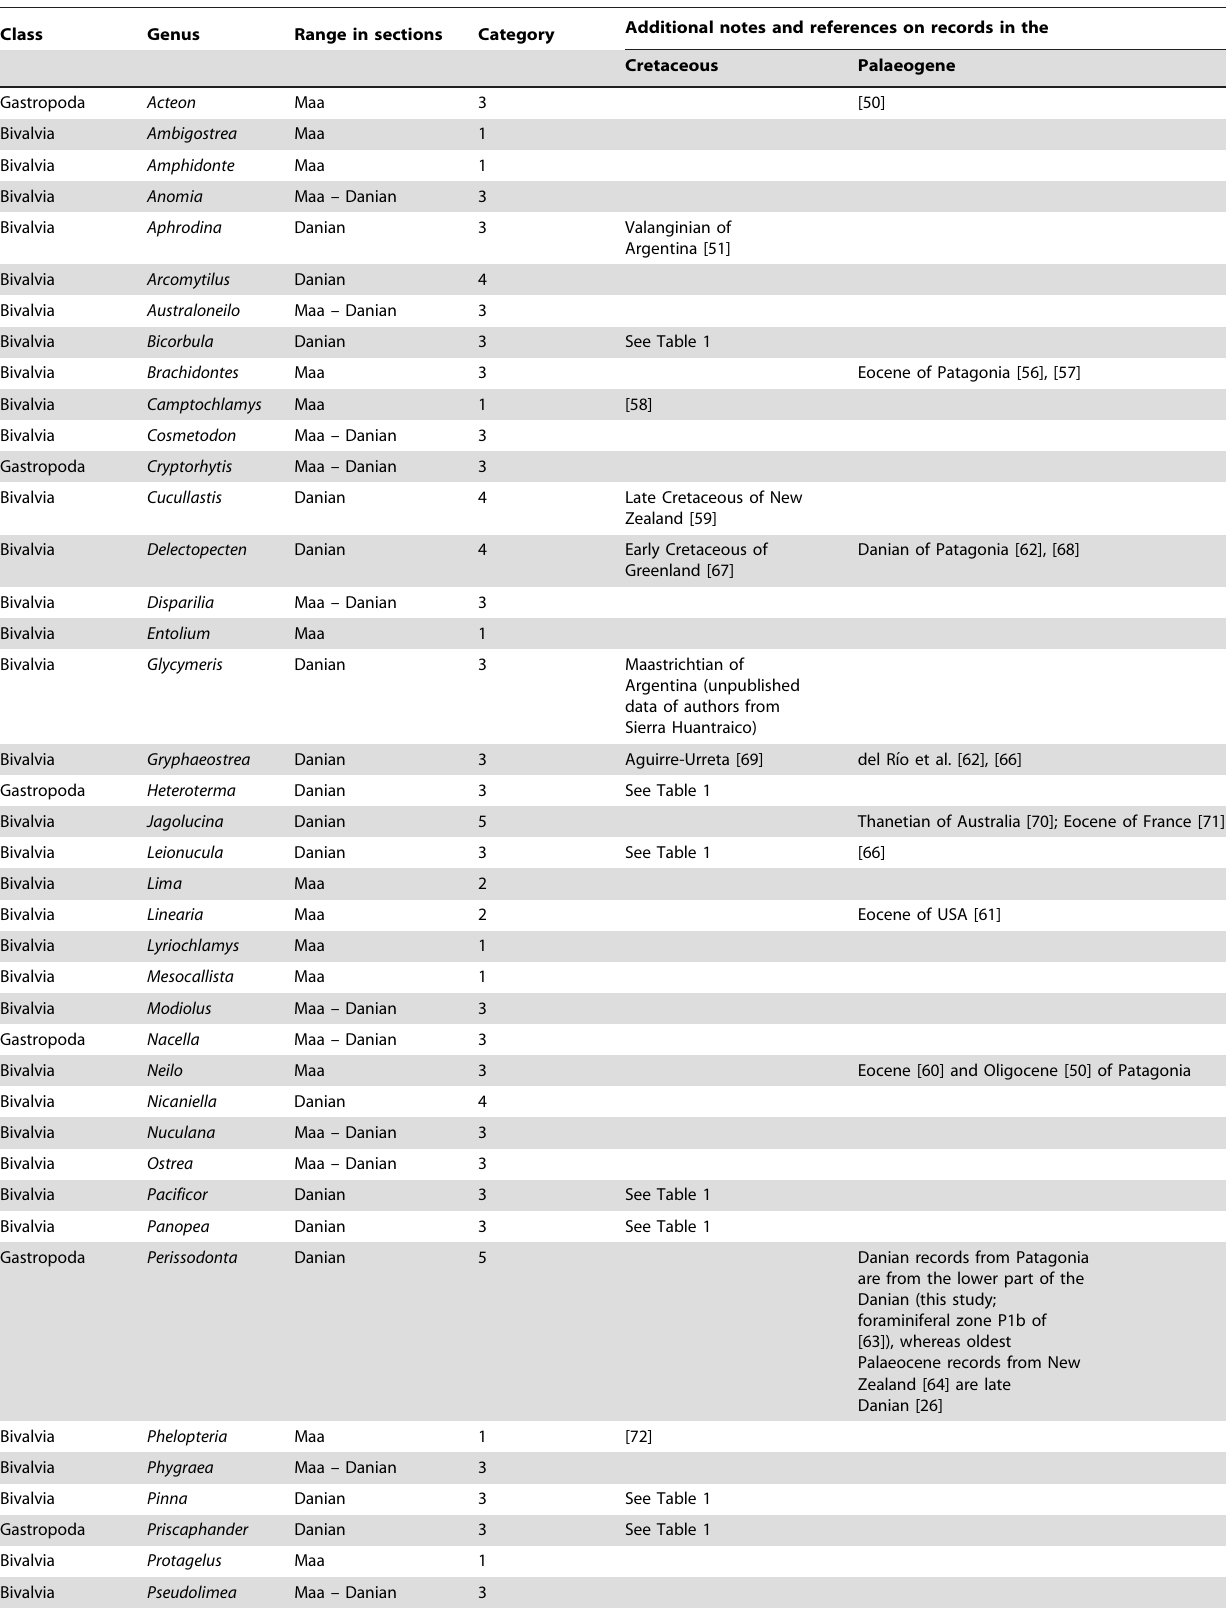
Table 2. Categorisation of molluscs at Bajada del Jagu¨el and Opaso.